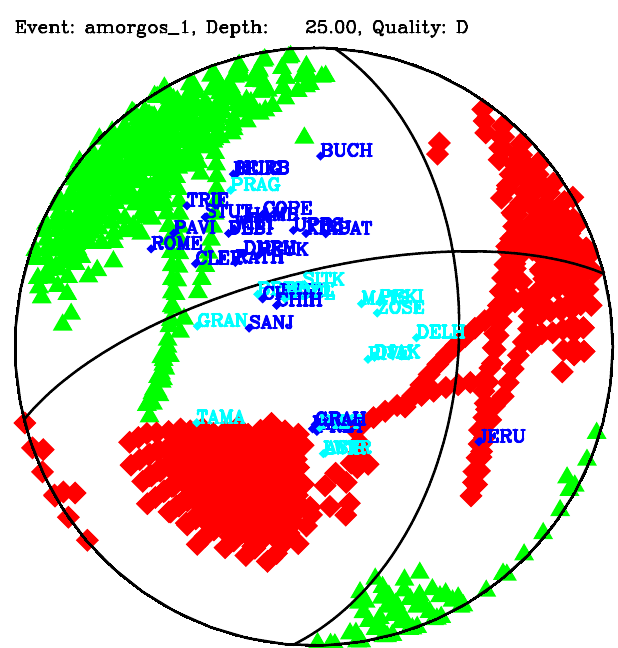
Figure 13. Compatible fault plane solutions obtained with the HASH method for first-motion polarities of the first Amorgos event taken from the ISS bulletin. Blue and turquoise dots with station names indicate positive and negative polarity, respectively. Red squares mark the piercing points of the P axes and green triangles indicate piercing points of the T axes. The nodal lines represent the average fault plane solution calculated by HASH.